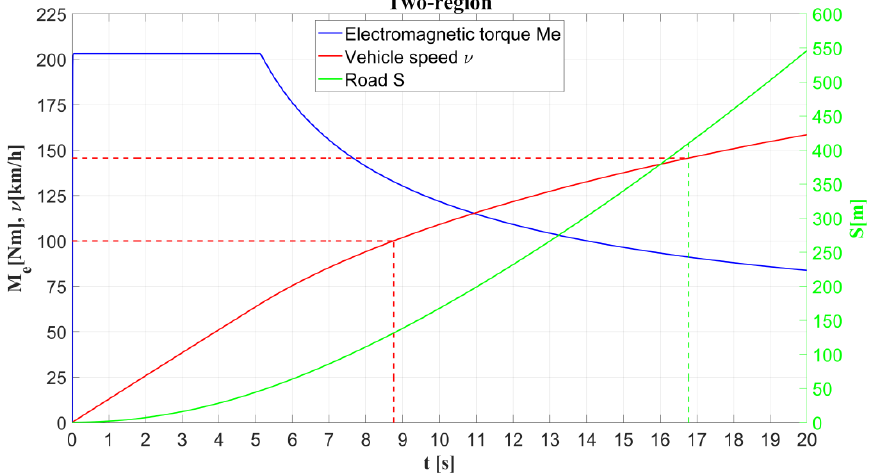
Figure 14. EV performance estimation for 2 × 100 kW IPMSM.